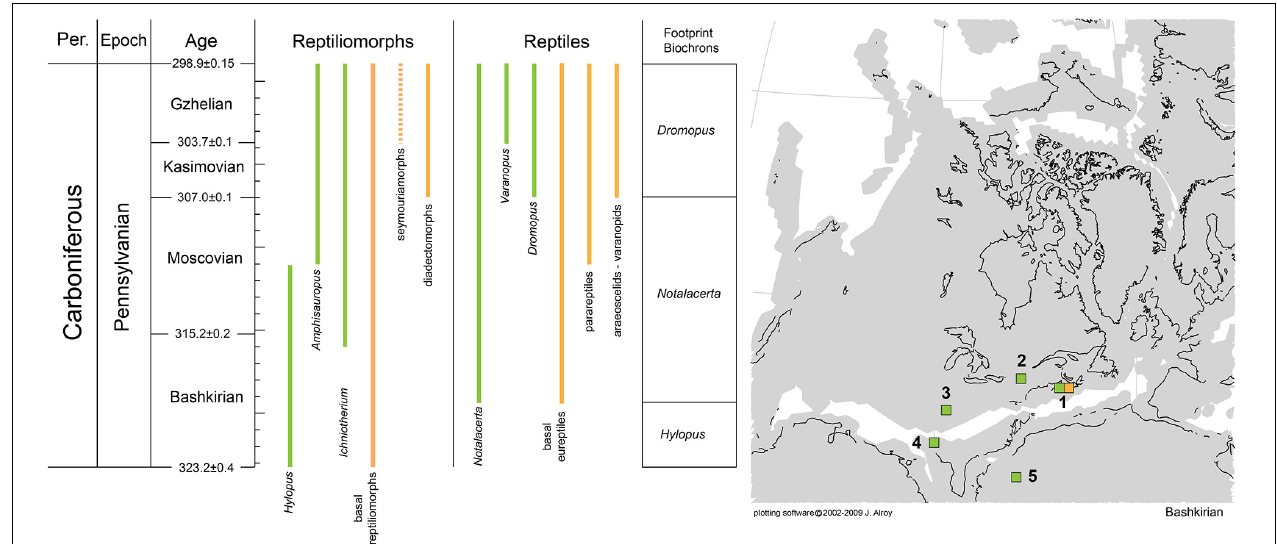
FIGURE 11 | Biostratigraphic ranges of anamniote reptiliomorphs and reptiles during the Carboniferous and paleobiogeography of reptiles during the Bashkirian. Skeletons in orange and ichnotaxa in green. Map from Alroy (2013),